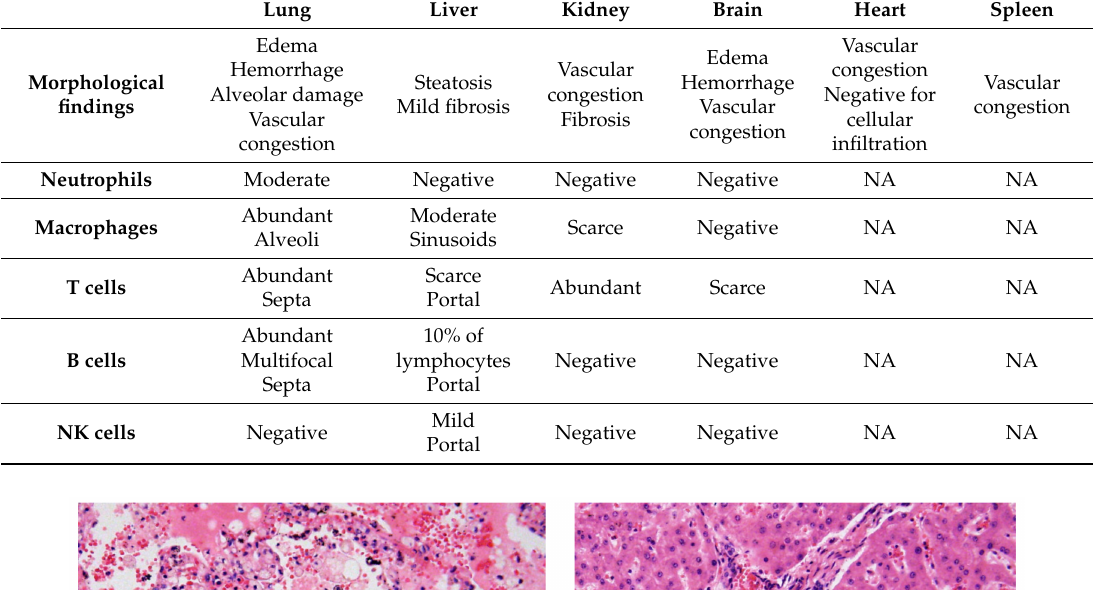
Table 2. Main findings in the histological analysis of the tissues.